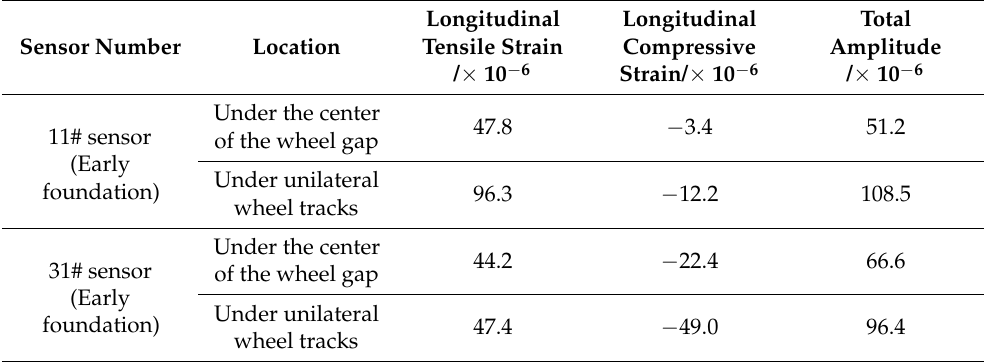
Table 2. The longitudinal strain at different position of the wheel